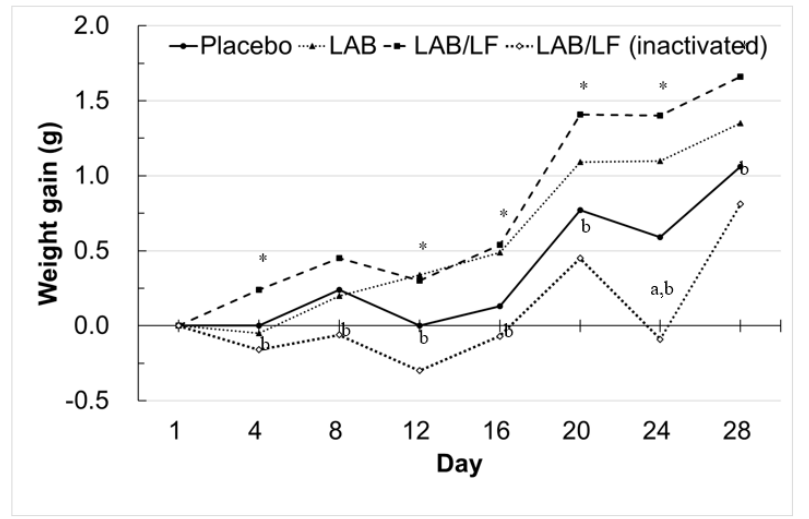
Figure 1. Growth curve (weight gain) in diet-induced obese (DIO) mice treated with three types of probiotic mixture. The treatment groups are detailed in the legend of Table 1. Briefly, DIO mice were fed with a high-fat diet and further supplemented with one of three probiotic mixtures by oral gavage daily for about four weeks. The mice were weighed twice a week during the study. The data represent group means. * The weight gains of LAB/LF mice were significantly higher than that of the placebo group. a The weight gains of LAB/LF (inactivated) mice were significantly lower than that of the placebo group. b The weight gains of LAB/LF (inactivated) were significantly lower than that of the LAB/LF group.